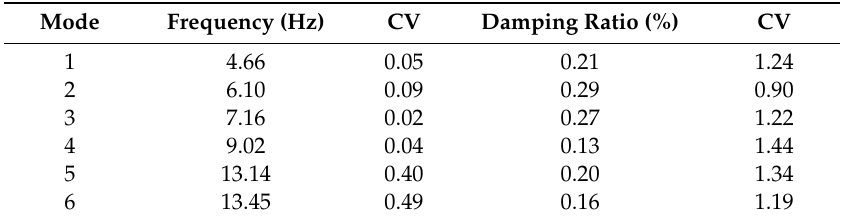
Figure 17. TF planes for the acceleration signal of DHF obtained by: ( a ) EWT; ( b ) SWT; ( c ) EMD. Table 3. Modal parameters identified from mono-components of